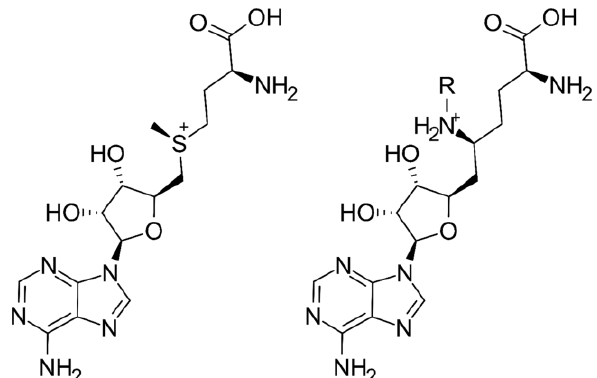
Figure 1. The 2D structures of S-adenosyl-methionine (SAM) (left) and sinefungin (SNF) (right). Substitution at the R group yields sinefungin analog SETD2 inhibitors with micromolar potencies (in the parent compound, the amine is unsubstituted).